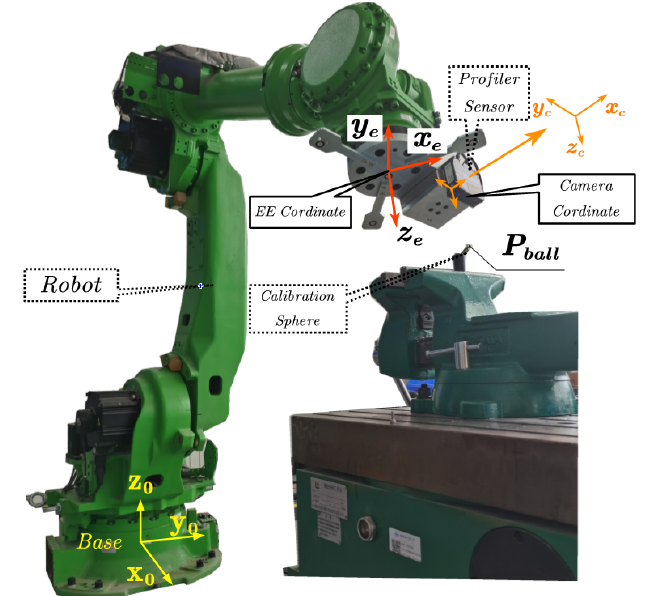
Figure 2. The calibration model of the robot line laser scanning